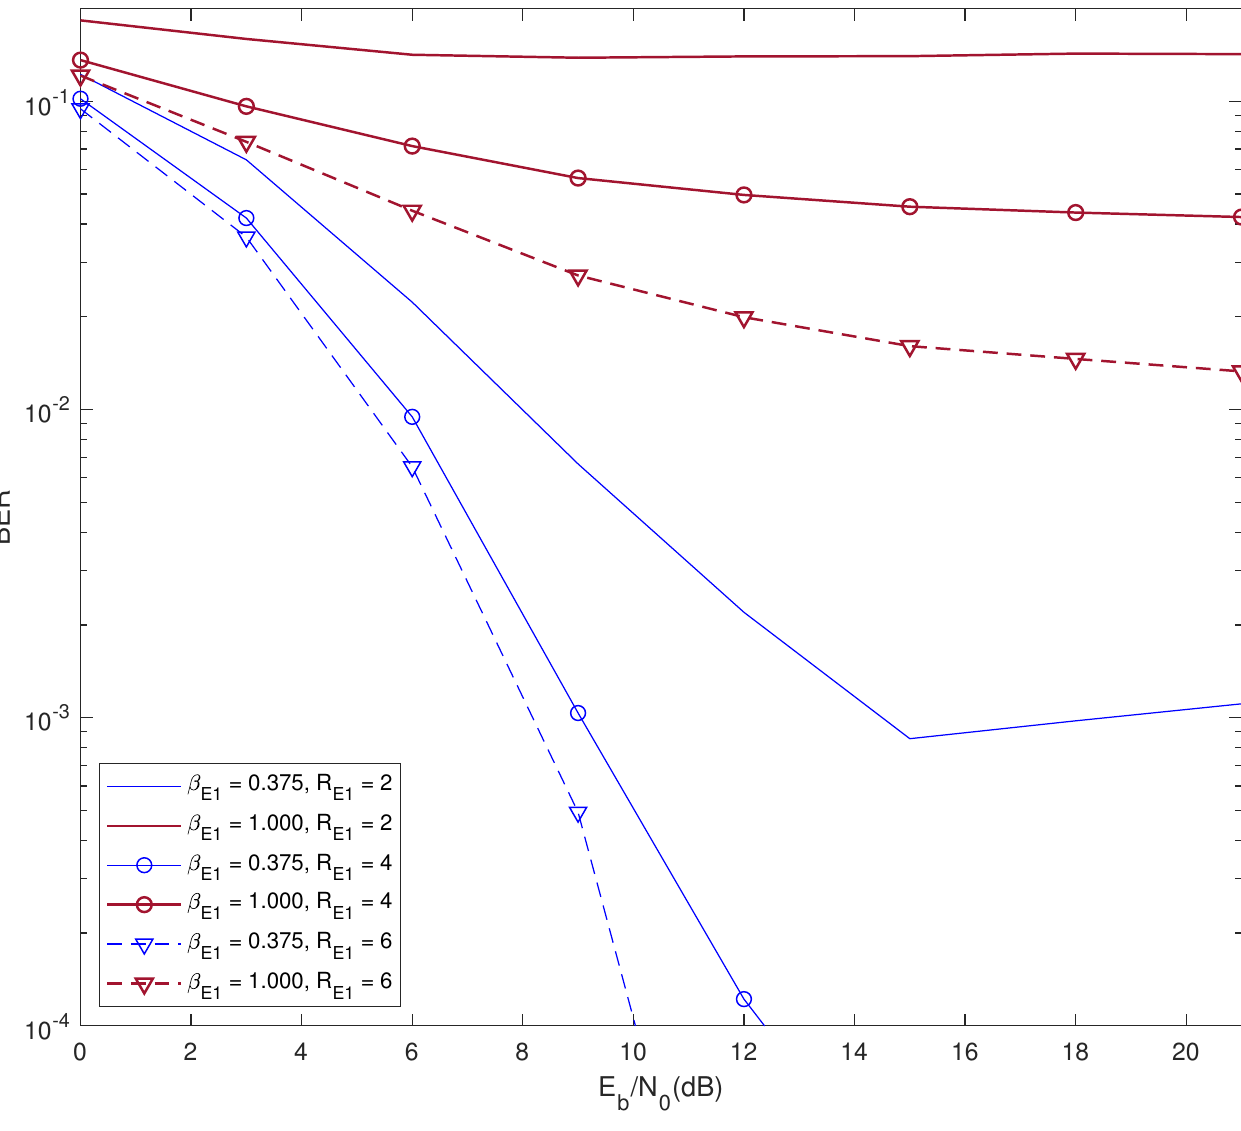
Figure 3. The BER results of E1 without the feedback of jamming signal estimate, where R E 1 = 2, T I = 1. Table 1 is an tabulation of Figure 2 values and, with this, β E 1 and β E 2 are calculated based on the path loss factor, distance between signal transmitting node and receiving node, and P J and P I